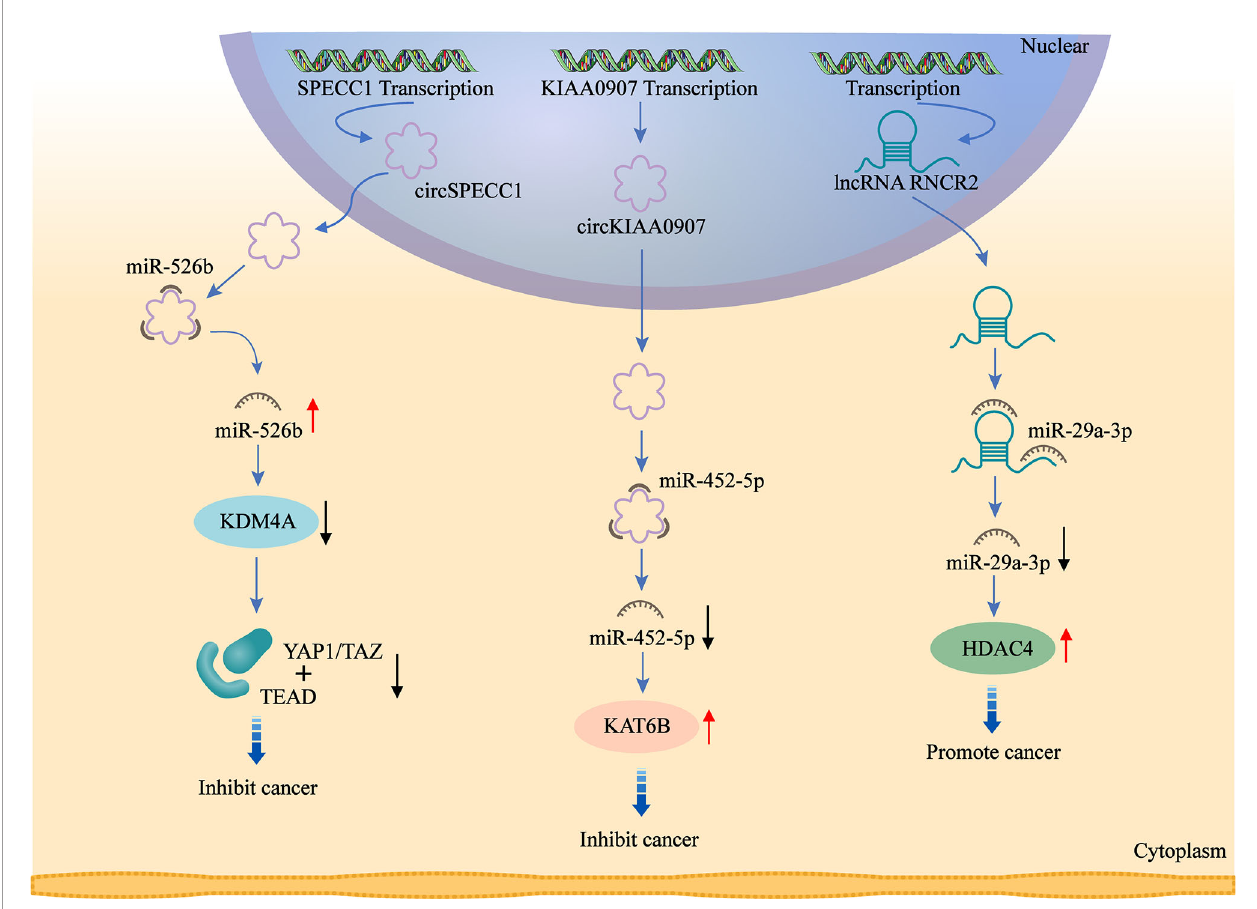
FIGURE 3 | ceRNAs are involved in the regulation of histone modi fi ers. circ_0000745 acts as a sponge for miR-526b and promotes KDM4A expression. circKIAA0907 acts as a sponge of miR-452-5P and promotes KAT6B expression. lncRNA MIAT acts as a sponge for miR-29a-3p and promotes HDAC4 expression. ceRNAs alter histone and non-histone modi fi cations by regulating the expression of histone modi fi ers, which affects downstream signaling targets and ultimately exerts their oncogenic or anti-tumor